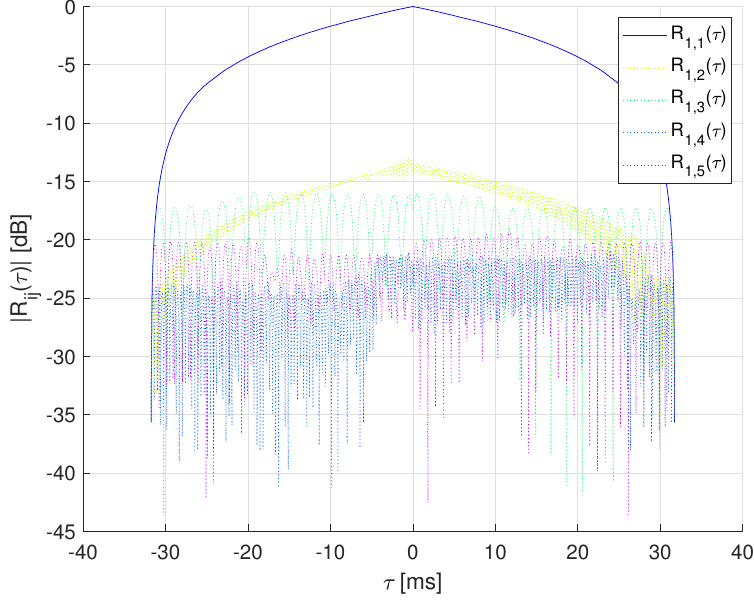
Figure 1. Cross-correlation functions [20] for g 1 ( t ) with T s = 31.75 ms.